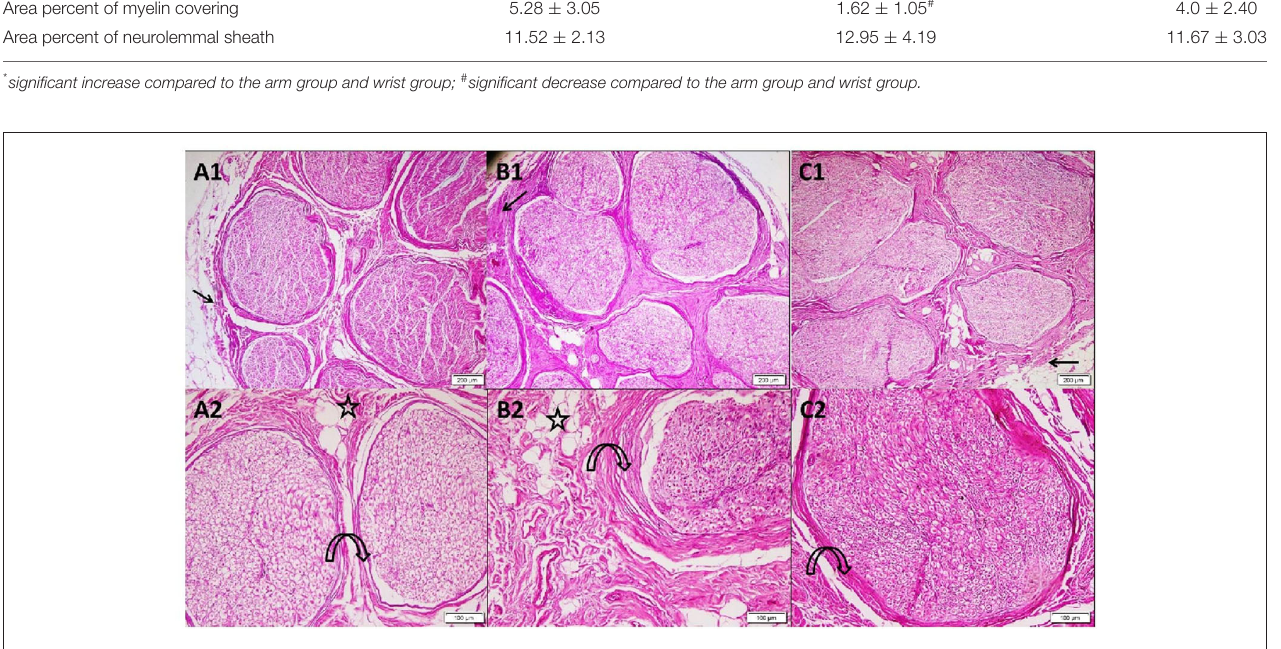
FIGURE 1 | Photomicrographs of transverse sections in cadaveric median nerve (H&E). Group A: (A1) nerve trunk from the arm with its outer covering epineurium (arrow). The nerve consists of multiple nerve bundles surrounded by connective tissue perineurium (4); (A2) a higher magnification demonstrating fascicles with the surrounding perineurium (curved arrow) adipose tissue present in between the fascicles (star) (10). Group B: (B1) nerve trunk from the forearm showing multiple nerve bundles surrounded by thick connective tissue perineurium (arrow) (4); (B2) a higher magnification demonstrating bundle with adipose tissue (star) in the surrounding thickened perineurium (curved arrow) (10). Group C: (C1) nerve trunk from the wrist surrounded by epineurium (arrow). The nerve consists of multiple nerve bundles surrounded by the connective tissue perineurium (4); (C2) a higher magnification demonstrating nerve bundle with its surrounding perineurium (curved arrow)